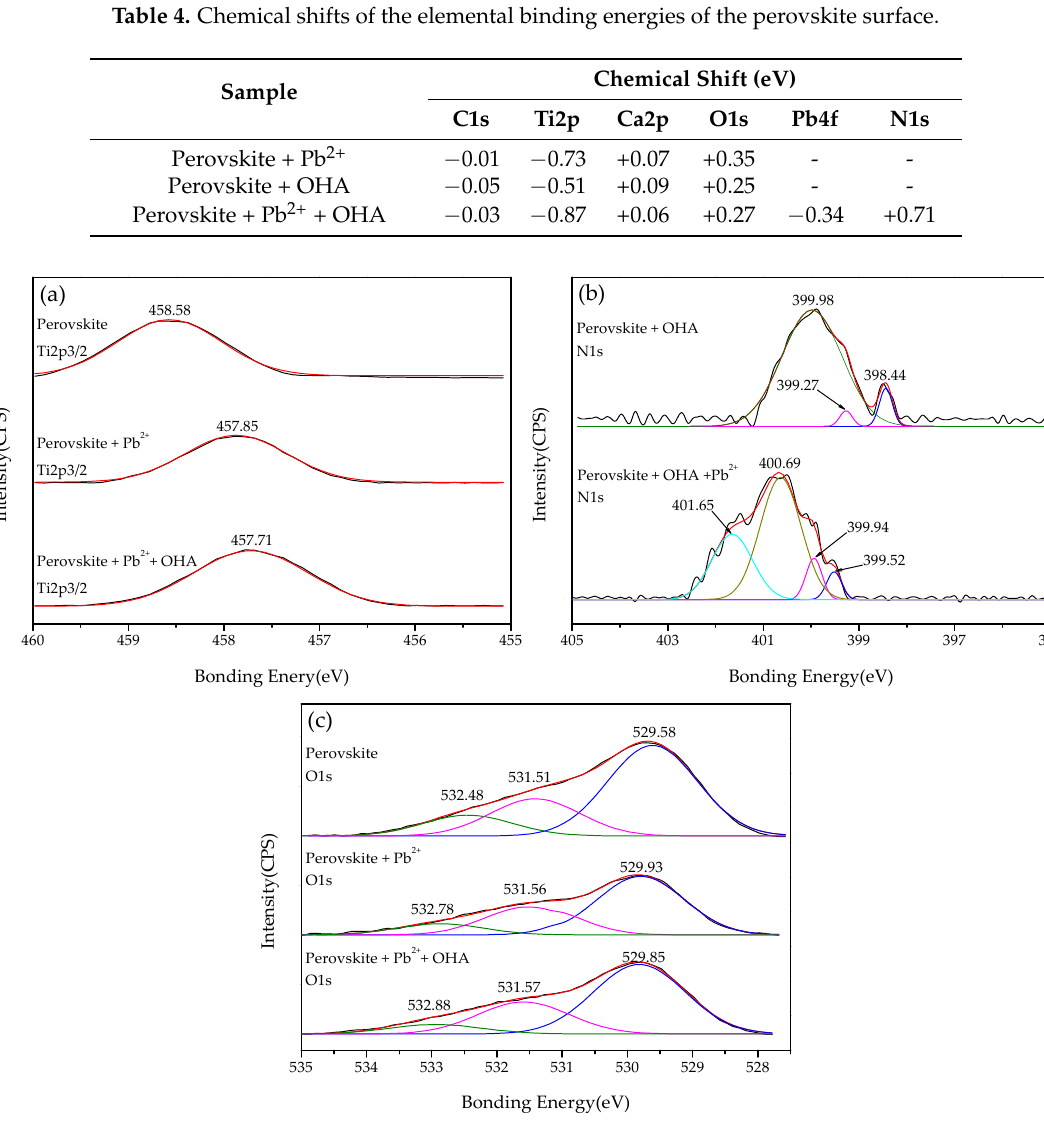
Figure 9. High ‐ resolution XPS spectra of perovskite before and after Pb 2+ and OHA treatment: ( a ) Figure 9. High-resolution XPS spectra of perovskite before and after Pb 2+ and OHA Ti2p, ( b ) N1s, ( c ) O1s. (Black line: original curve, red line: fitted curve, other colors line: curve of XPS ‐ peak ‐ differentiation ‐ imitating analysis)